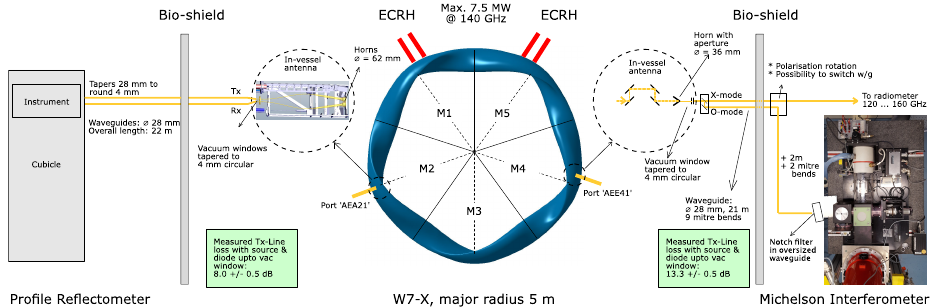
Figure 1: Michelson and Profile Reflectometer waveguide systems at